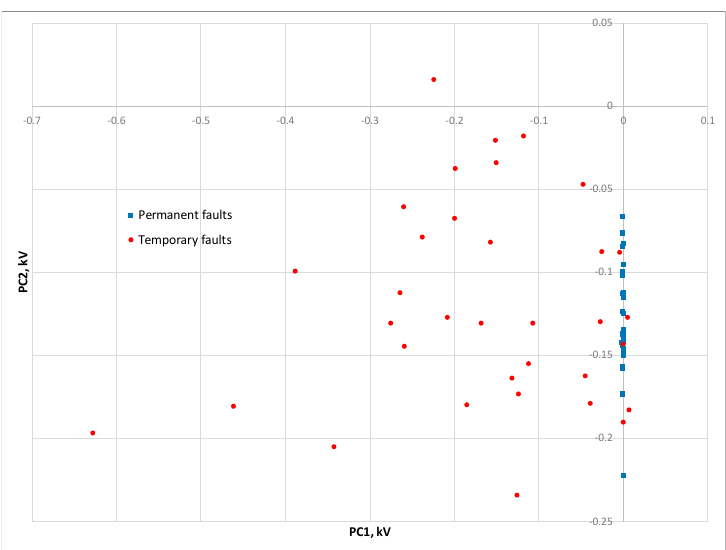
Figure 6. Permanent and temporary faults in the first and second subspace of Principal Components (PCs).